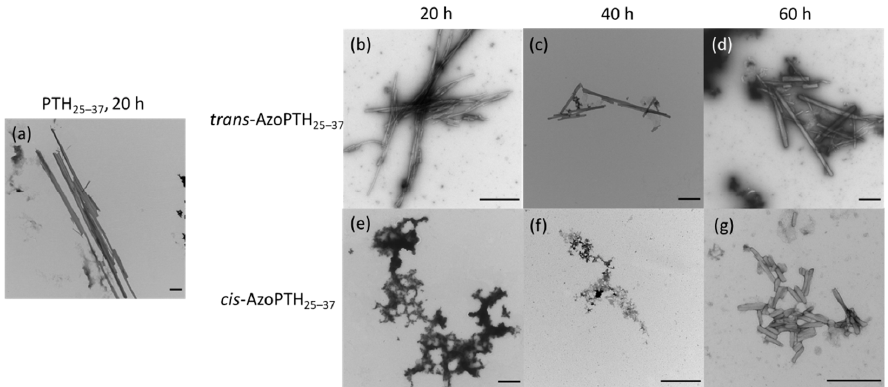
Figure 5. TEM recordings of fibrils obtained from PTH 25–37 , cis- AzoPTH 25–37 , and trans -AzoPTH 25–37 at ( T = 37 °C, buffer = 50 mM Na 2 HPO 4, pH = 7.4) after different time points (all scale bars corresponds to 500 nm). ( a ). PTH 25–37 after 20 h, ( b ) trans- AzoPTH 25–37 after 20 h (100 μ M), ( c ) trans- AzoPTH 25–37 after 40 h (100 μ M), ( d ) trans- AzoPTH 25–37 after 60 h (100 μ M), ( e ) cis- AzoPTH 25–37 after 20 h (100 μ M), ( f ) cis- AzoPTH 25–37 after 40 h (100 μ M), and ( g ) cis- AzoPTH 25–37 after 60 h (100 μ M).